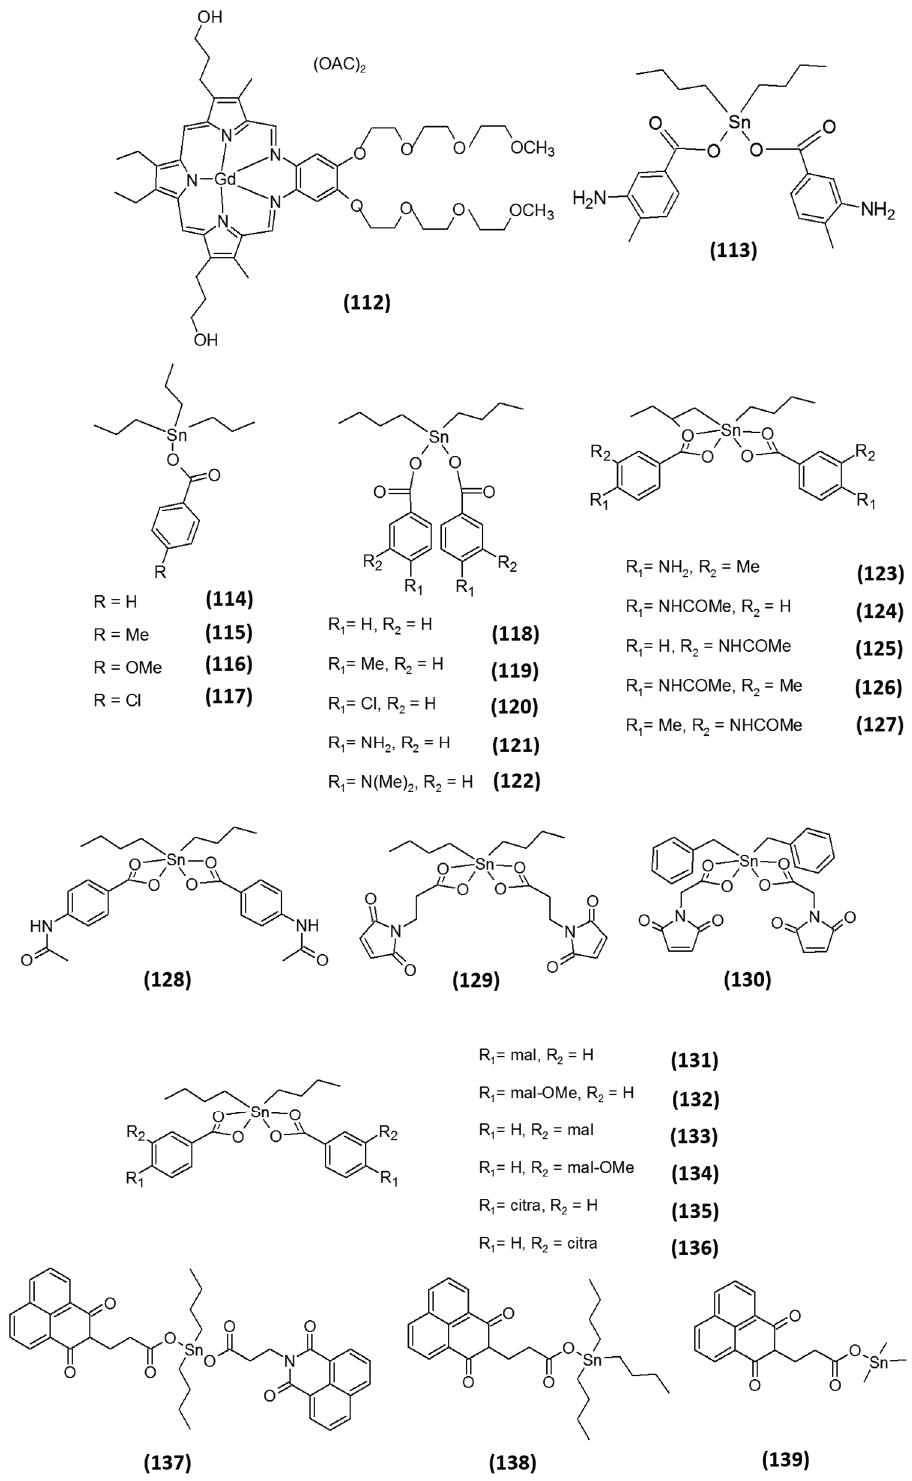
Figure 7. Structures of other metal-based